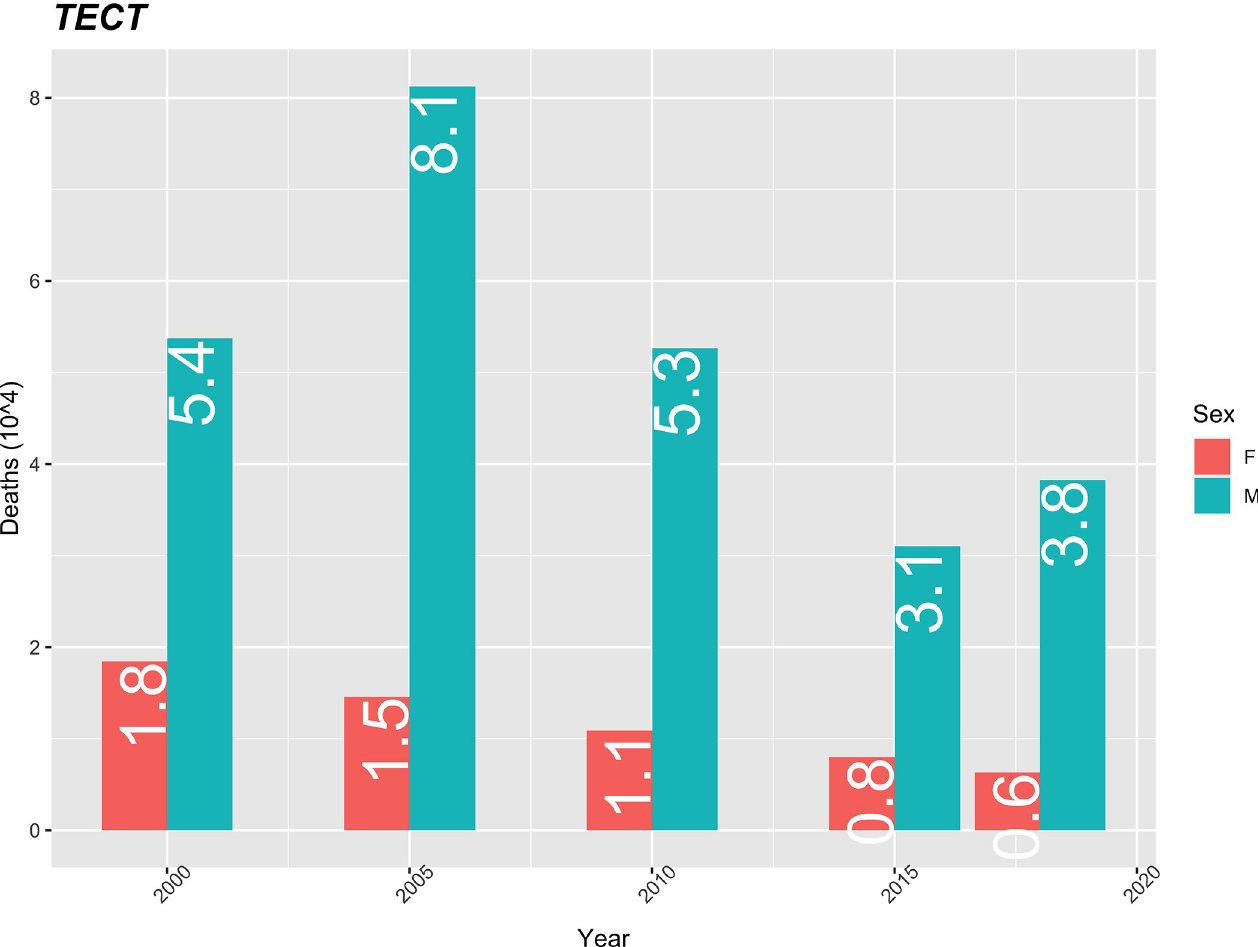
Fig 9. Mortality rate per TECT (10 thousand) standardized by age, using the population of Cape Verde in 2010 as the standard.